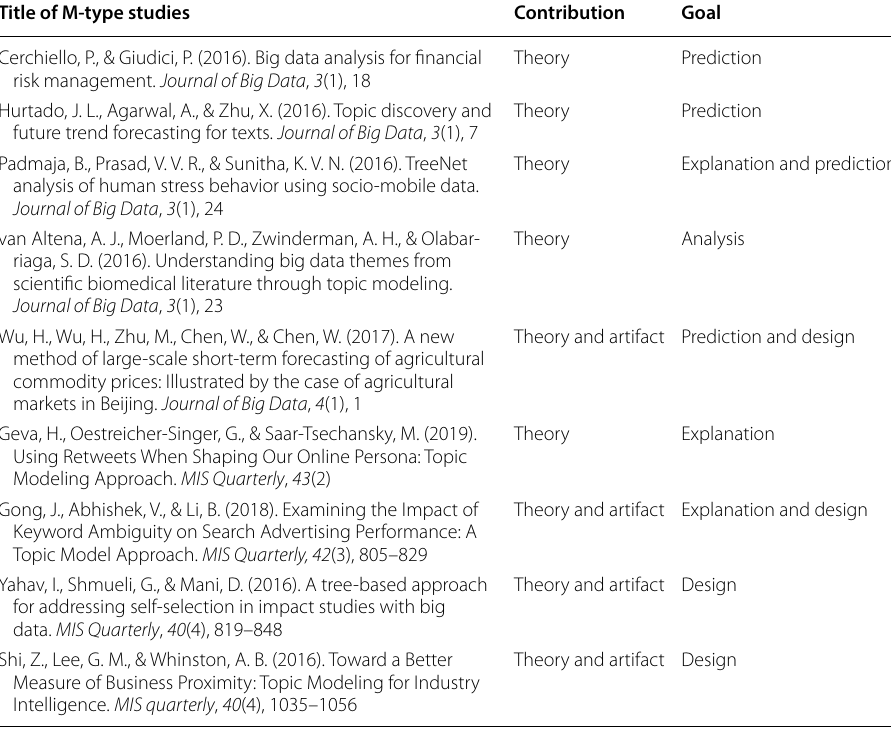
Table 5 Sample of studies using data science as a